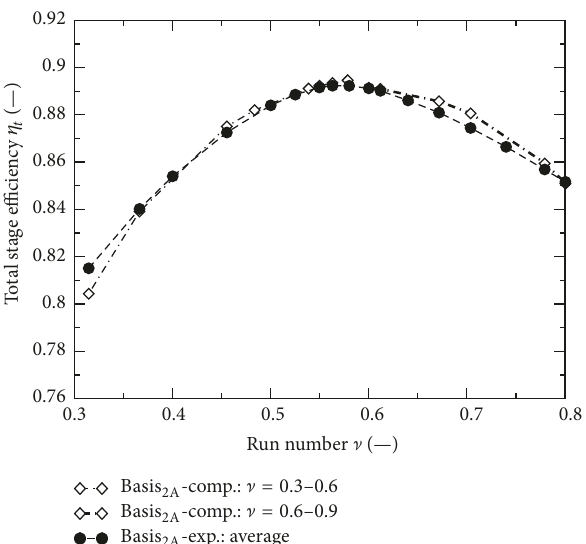
Figure 5: Total stage efficiency as a function of the run number ] for the radial blade Basis2A with real axial gap 6.5 mm.